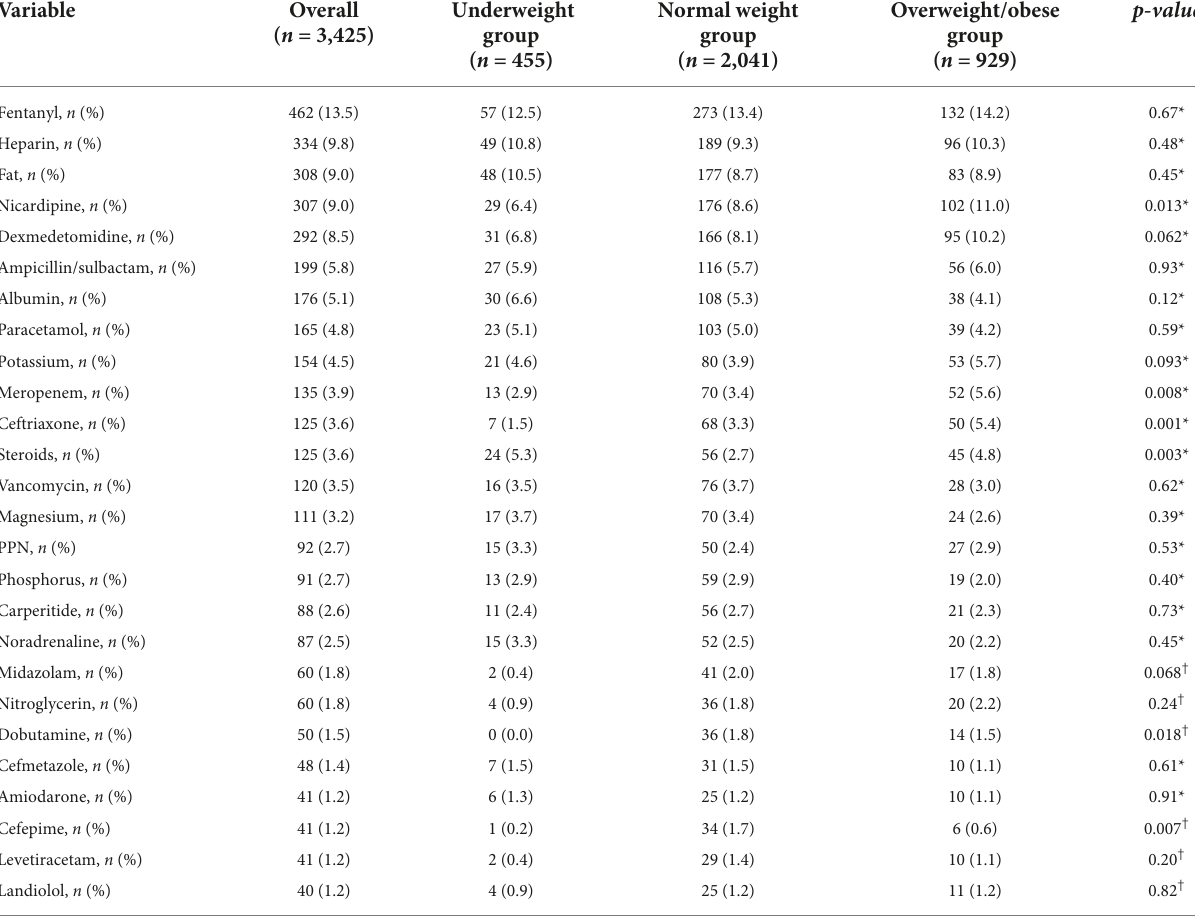
TABLE 3 Characteristics of the drugs administered with the catheter in situ stratified by body mass